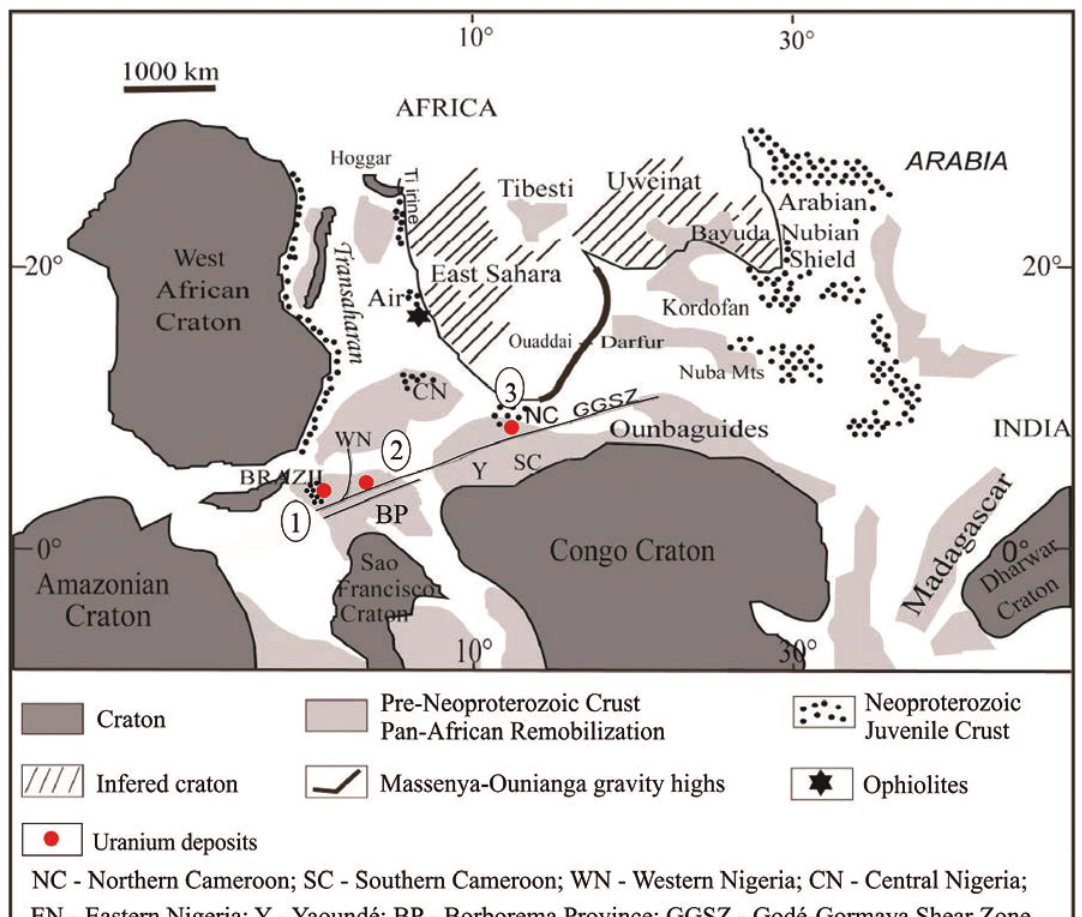
Figure 12 - Geological sketch map of West Gondwana with location of uranium deposits: 1 – Itataia; 2 – Espinharas; 3 – Kitongo (modified from Kouske et al .